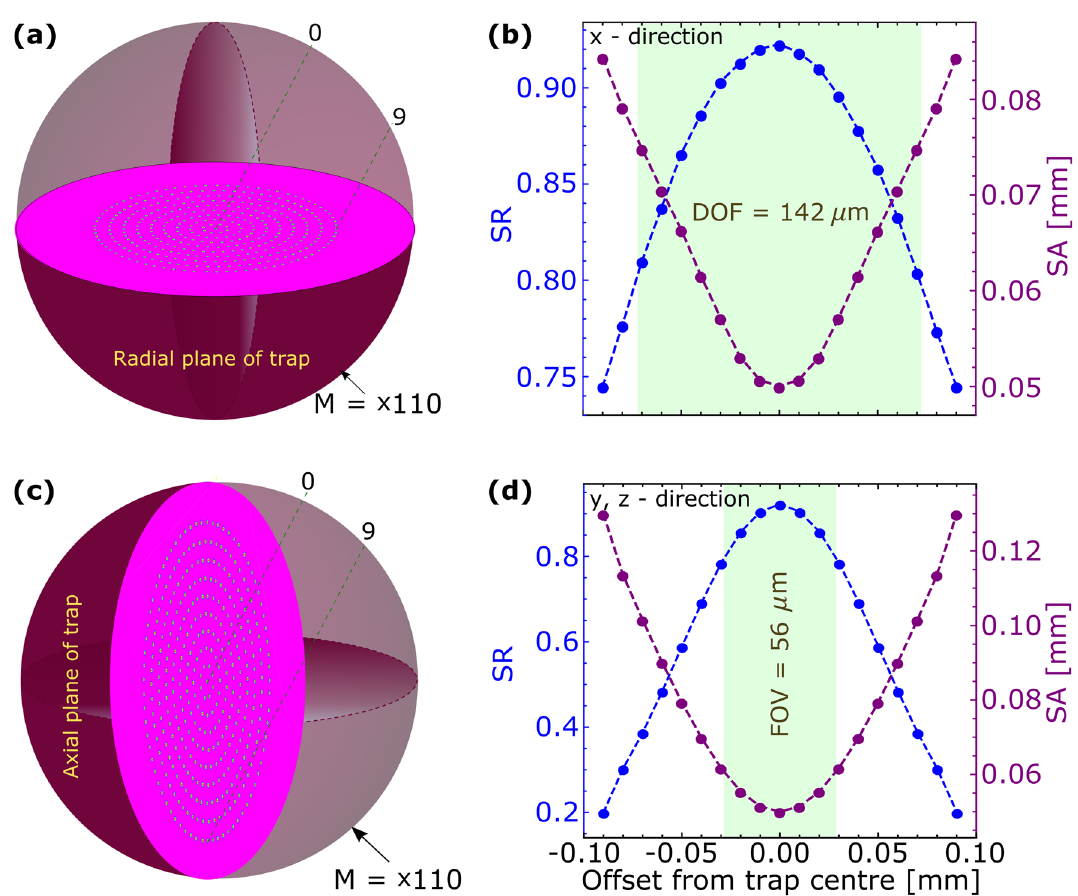
Figure 4. Images of trapped ions on ( a ) xy , ( c ) yz planes. ( b ) and ( d ) shows corresponding variation of SR and SA as the ion’s position deviates from best focus. Depth of field (DOF) and Field of View (FOV) are